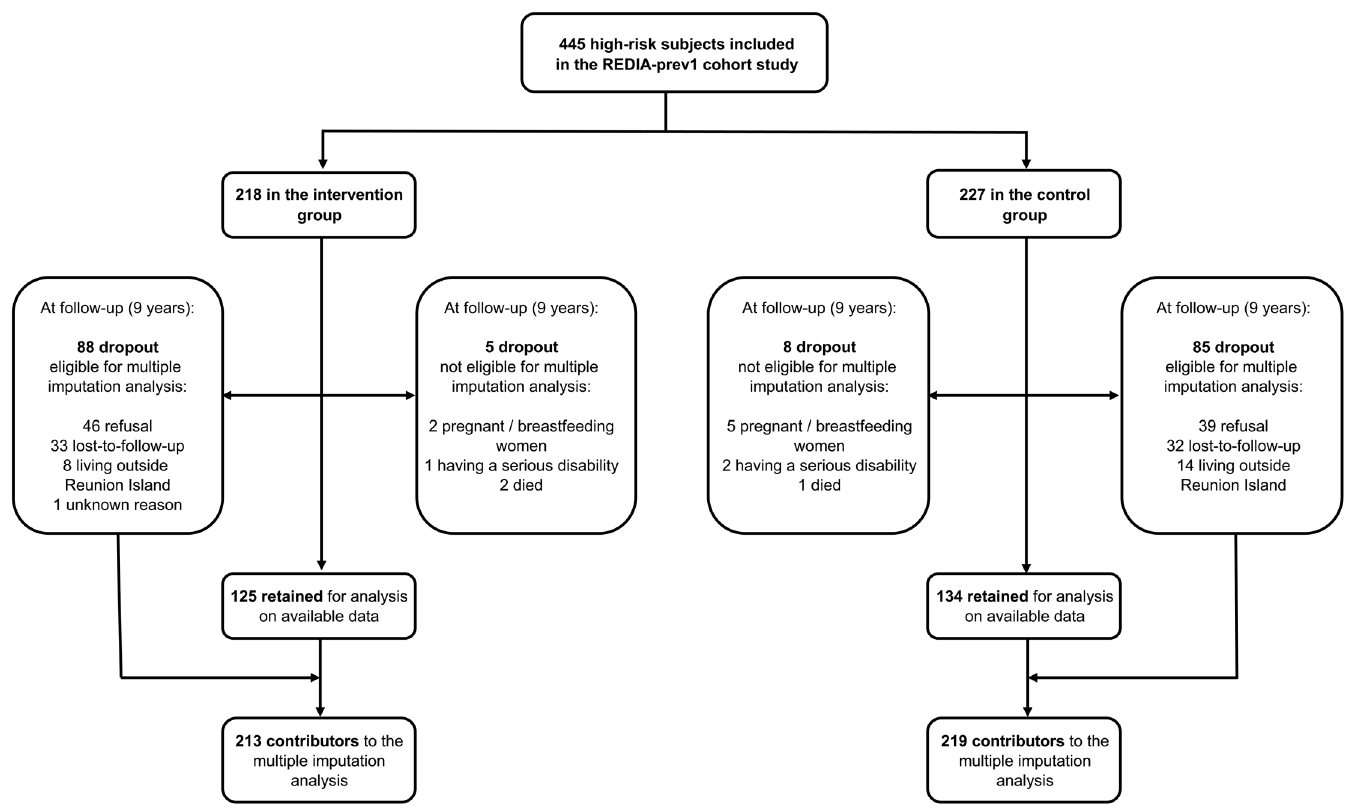
Fig 1. Selection of the participants for the long-term evaluation analyses in the REDIA-prev1 cohort study. (Reunion Island, 2001 – 2011).